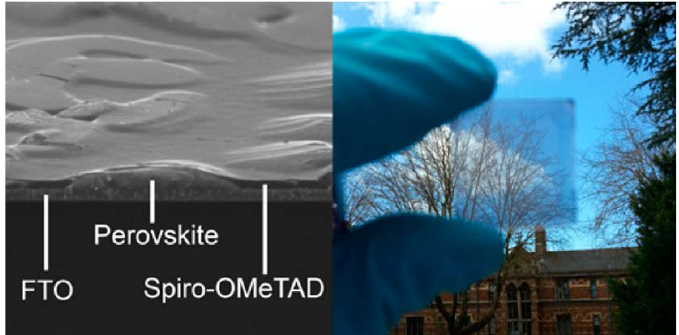
Figure 4. Micro-island structure observed by scanning electron microscopy and image of the semitransparent perovskite-based solar cell. Reprinted with permission from “Neutral Color Semitransparent Microstructured Perovskite Solar Cells”, ACS Nano 2014, 8, 1, 591–598. Copyright (2013) American Chemical Society”.